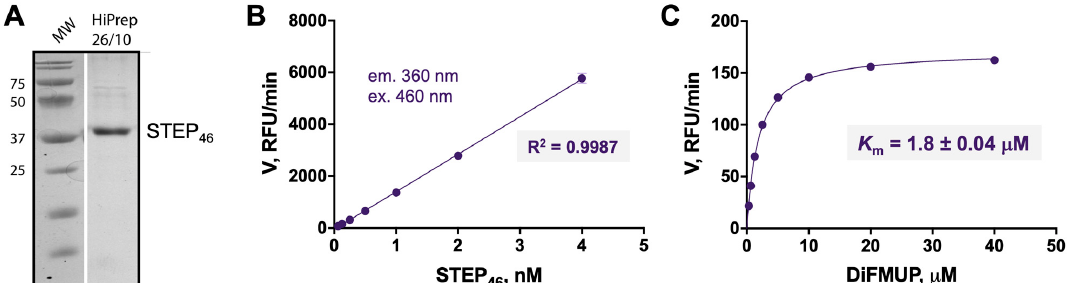
Figure 3. ( A ) SDS PAGE of full-length human STEP 46 (MW 44.3 kDa) after expression of HIS-tagged fusion protein using a custom-made codon-optimized vector, and purification using Ni-affinity chromatography and subsequent processing over an S75 size exclusion chromatography column. ( B ) Titration of STEP 46 in a phosphatase activity assay in 384-well format using 6,8-difluoro-4-methylumbelliferyl phosphate (DiFMUP, 50 μ M) as a substrate. Fluorescence intensity was measured in kinetic mode to determine the initial rates ( V ) from the slopes of the progress curves. The initial rates were found highly correlative with the various STEP 46 concentrations tested, as demonstrated by the linear regression coefficient (R 2 ). ( C ) Michaelis–Menten kinetics for STEP 46 (0.5 nM) and DiFMUP using a similar assay format as described in ( B ). The Michaelis–Menten constant ( K m ) was calculated by fitting initial rates to the Michaelis–Menten equation using the program GraphPad Prism.